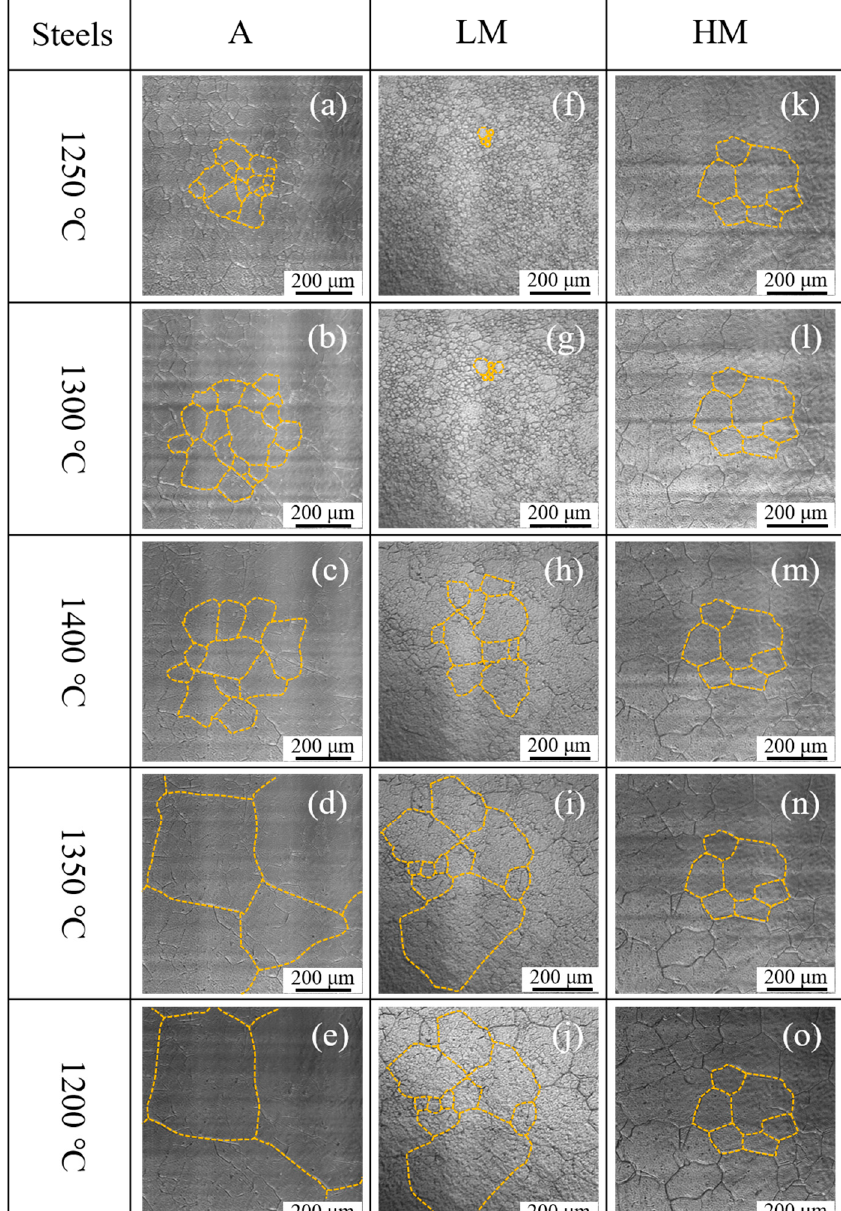
Figure 10. In situ observation of austenite grain growth during the high-temperature stage: ( a – e ) A, ( f – j ) LM, and ( k – o ) HM.